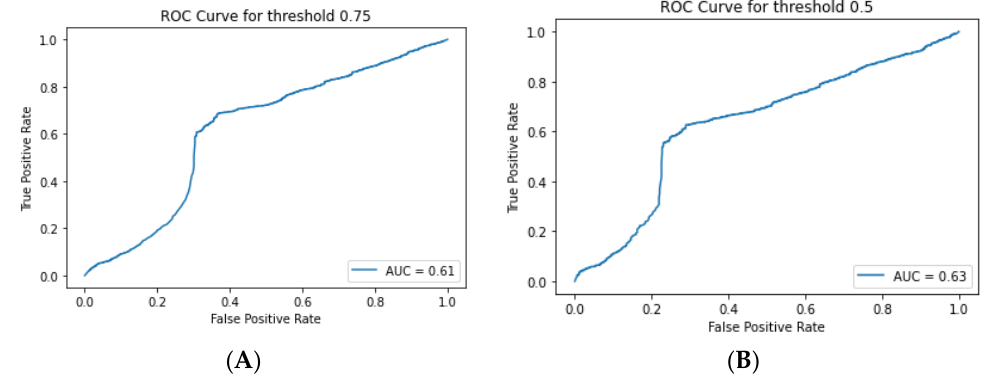
Figure 3. ( A ) Receiver operating characteristic (ROC) curve using Botometer with CAP score of 0.75. ( B ) Receiver operating characteristic (ROC) curve using Botometer with CAP score of 0.5.